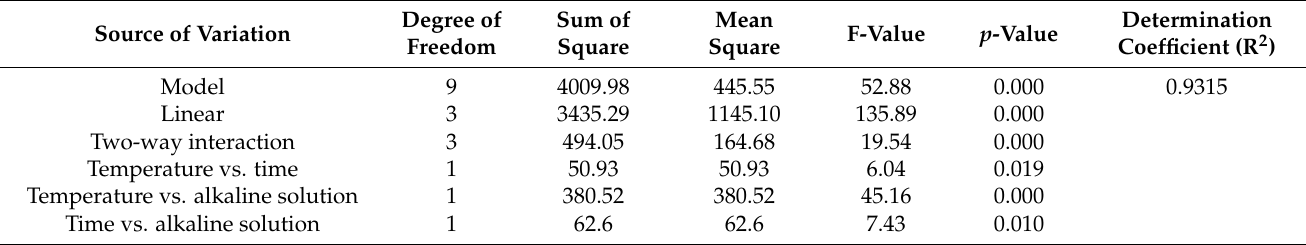
Table 5. ANOVA for the quadratic model.